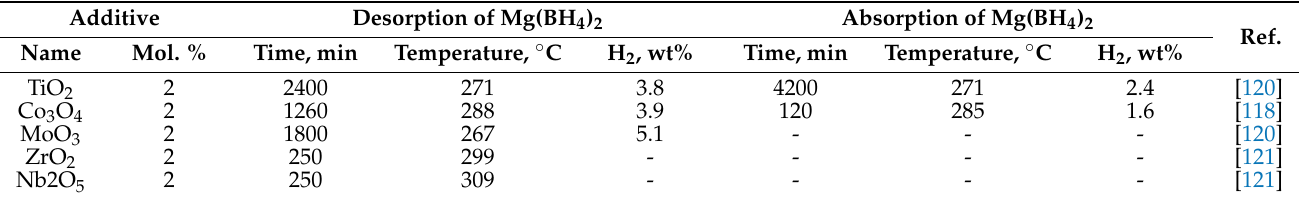
Table 5. Effect of several metal oxides on the desorption and absorption of Mg(BH 4 ) 2